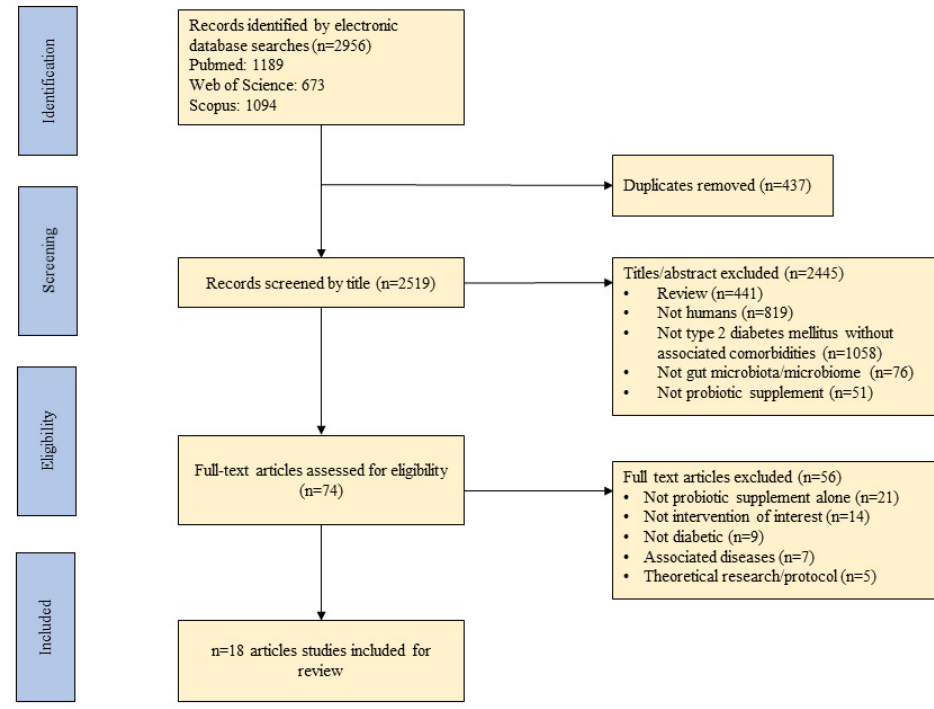
Figure 1. A flow diagram detailing the process followed for the selection of the studies for the integrative review.